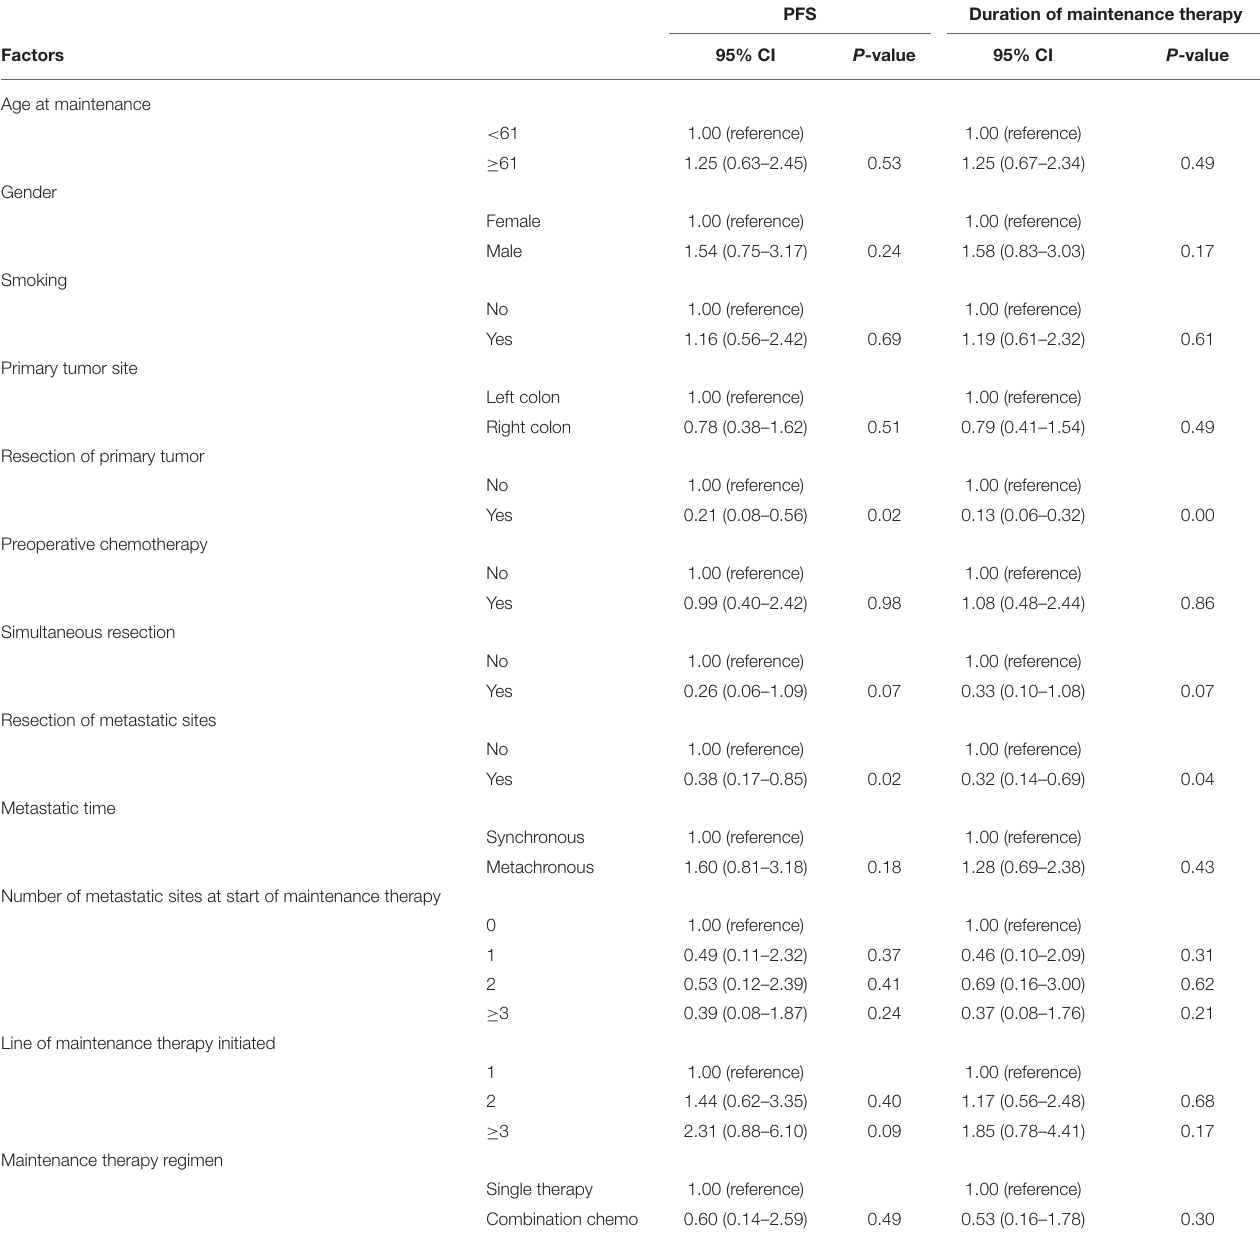
TABLE 3 | Univariate analyses for PFS and duration of maintenance therapy in Bev